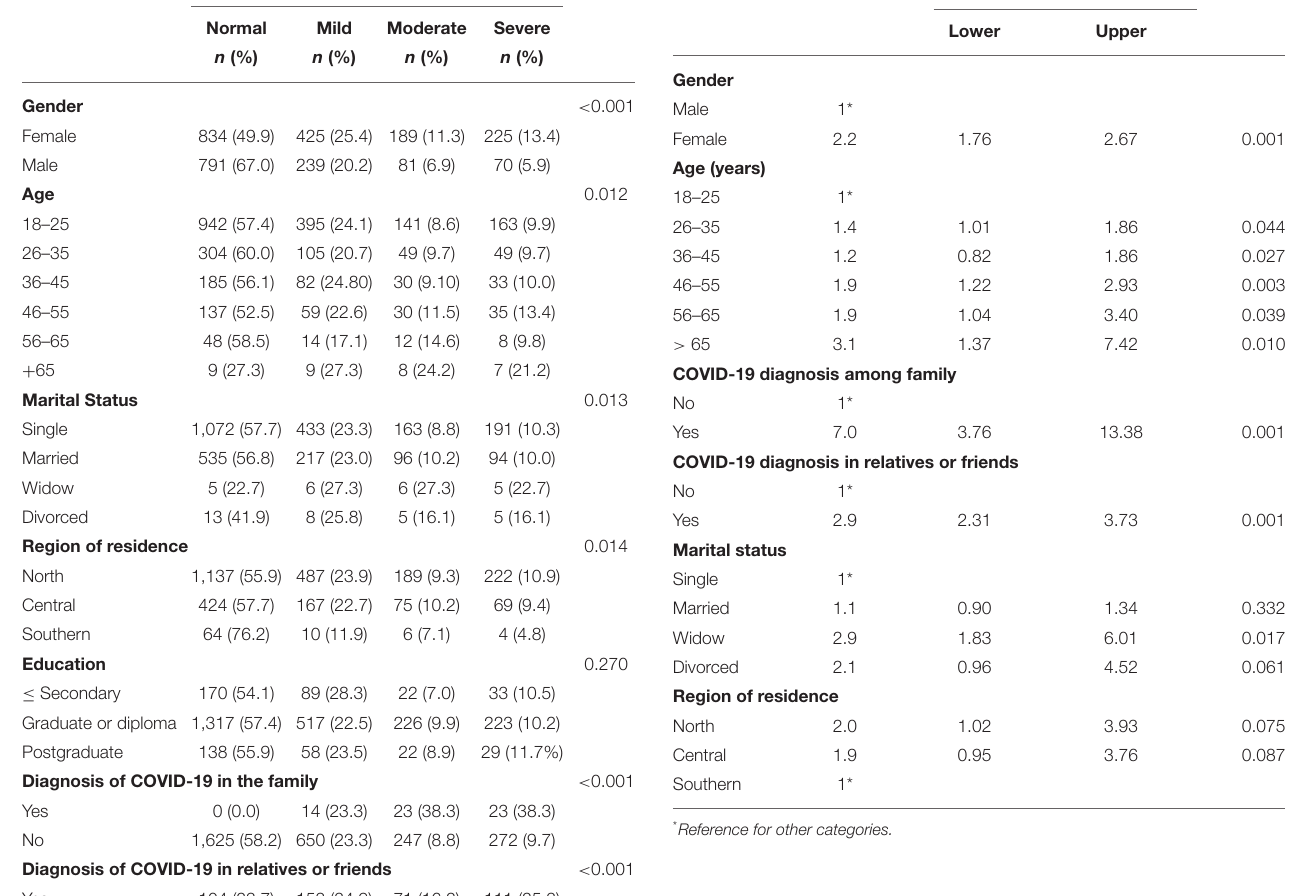
TABLE 3 | Logistic regression analysis of factors associated with an increased impact of event scale—revised score. Variable Odds